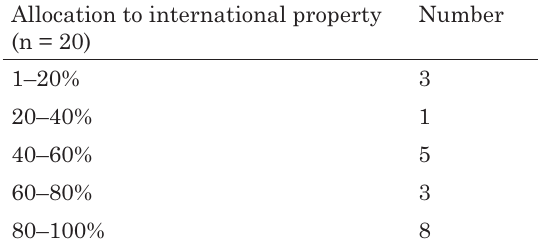
Table 4. Allocation to international